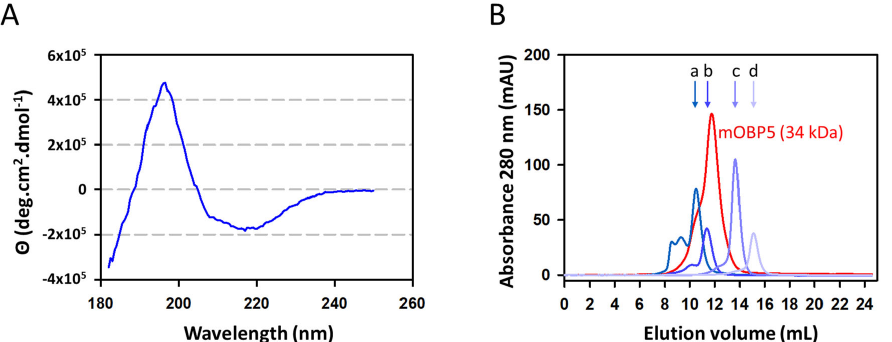
Figure 2. Secondary structure analysis and molecular weight estimation of mOBP5. ( A ) Circular dichroism analysis of mOBP5. The far ‐ UV spectrum was recorded in 50 mM NaF buffer at pH 7.5 with 15 μ M protein using a cuvette path length of 0.1 mm. ( B ) Exclusion ‐ diffusion chromatography on a Superdex 75 column of mOBP5. The elution positions of the molecular mass standards are indicated by arrows: a, bovine serum albumin (67 kDa); b, chicken egg ovalbumin (43 kDa); c, ribonuclease (13.7 kDa); d, aprotinine (6.5 kDa).